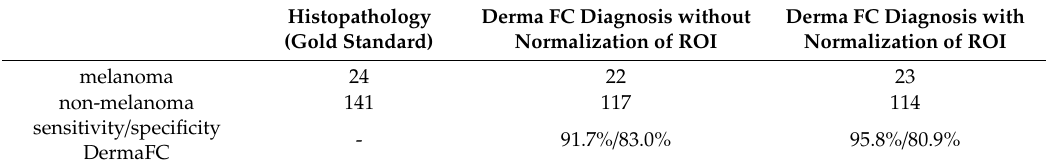
Table 1. Diagnostic accuracy of the dermatofluoroscopy validated on 165 lesions with and without region of interest